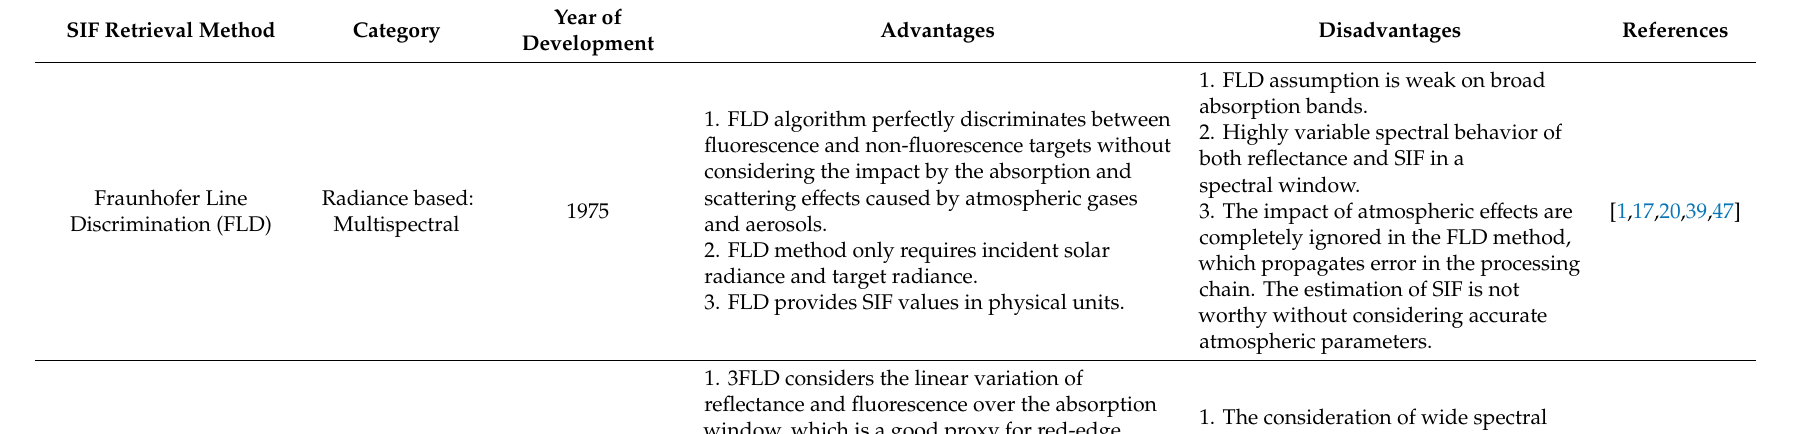
Table 1. Summary of the sun-induced fluorescence (SIF) retrieval